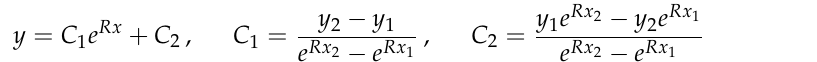
Figure 1h delivers the Hilbert curve structure in the third iteration with the total length of the slot ( l h ), the line segment ( dd ), and iteration ( in ) follows Equation (2) [47]. In this case, we use 3rd iteration. the exponential growth rate with the value of R 1 R 2 , R 3, and R 4 shown in Table 1 (based on Figure 1a. The beginning and ending points of an exponential curve are x 1 , y 1 , x 2 , and y 2 Figure 2c,d show the vertical and horizontal wave slots. The Constant of the wavy [44]. slot in Equation (3) is B 1 = 2, B 2 = 1, B 3 = 1, B 4 = 5, and B 5 = 36. The depth of the wave, the number of waves, and the length of the wave slot can all be modified by changing the value of B n [48]. Table 1. Parameter dimension of the antenna. Dimension (mm)